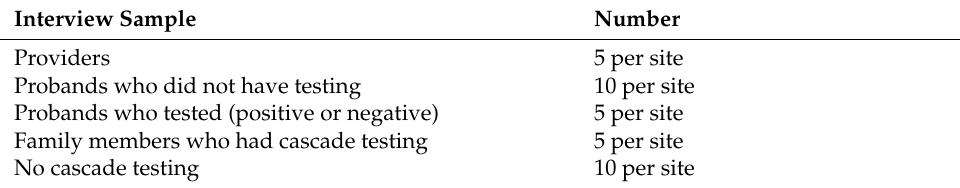
Table 5. Aim 4 data